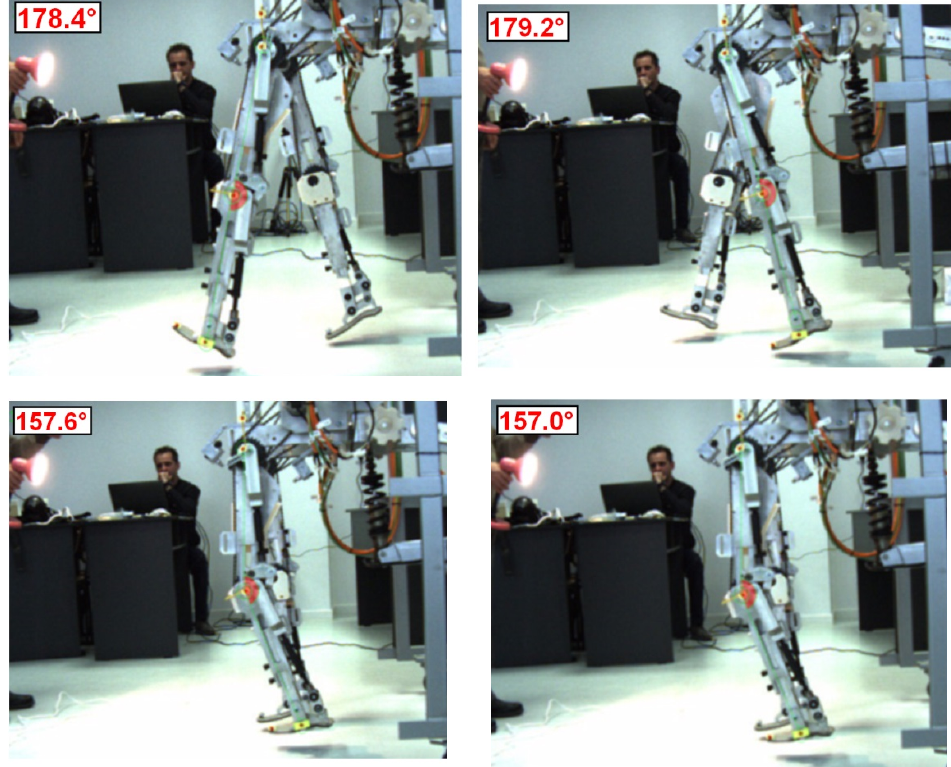
Figure 25. Snapshots during exoskeleton left knee joint without foot and ground contact.